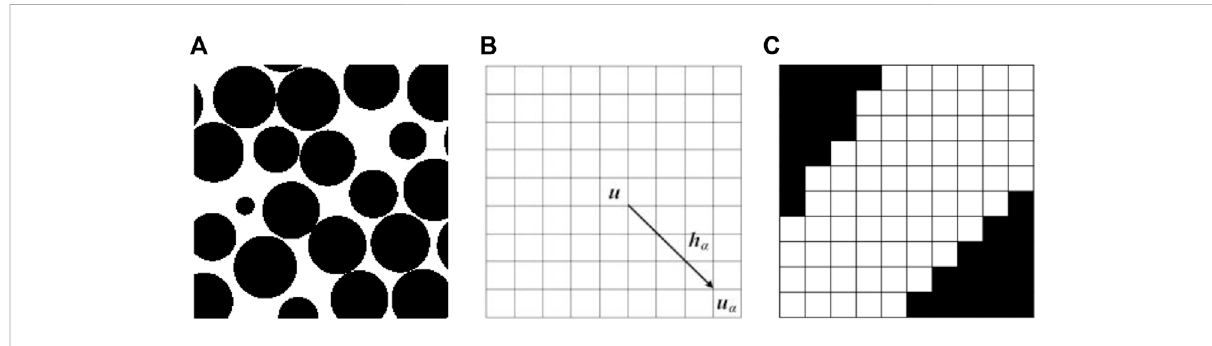
FIGURE 1 Illustrationof (A) animageusedfortrainingpurposes,splitintoagrainphase(black)andaporephase(white), (B) a9×92Ddatatemplate,and (C) a data event acquired after a 9×9 2D data template scanned the training